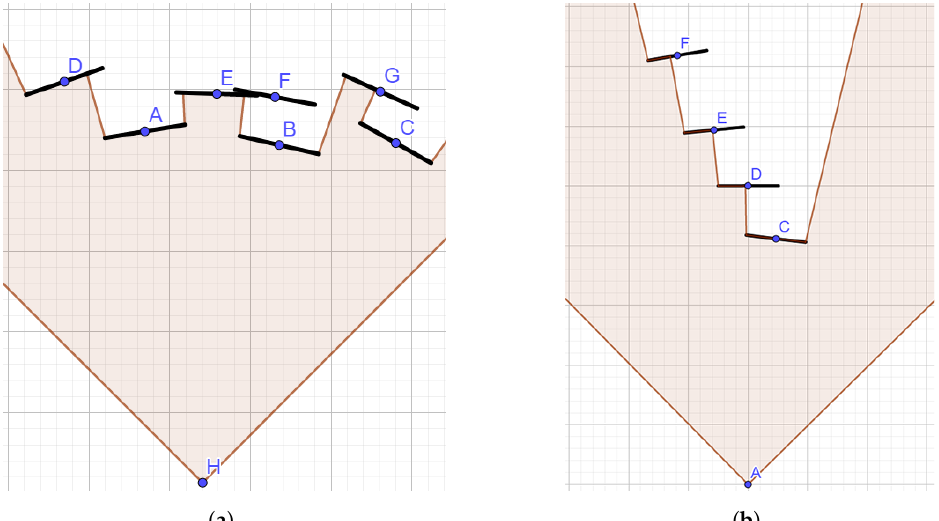
Figure 3. Point filtering with use of depth map. ( a ) Points F and G are filtered out, since they are occluded by points B in C; ( b ) a side view on the surface defined with points C–F. Point C occludes point D, which in turn occludes point E, which in turn occludes point